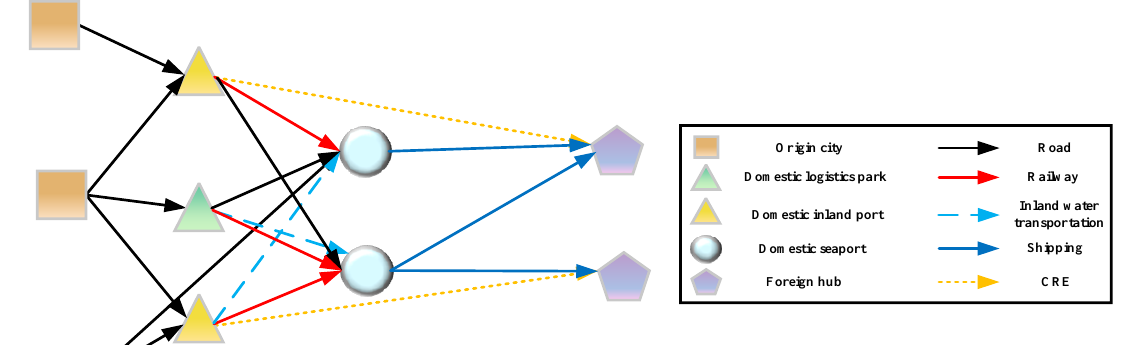
Figure 2. The network studied in this paper.